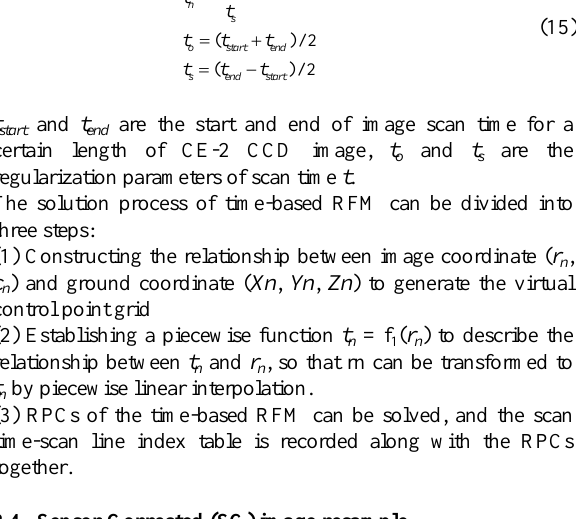
fitting precision will be